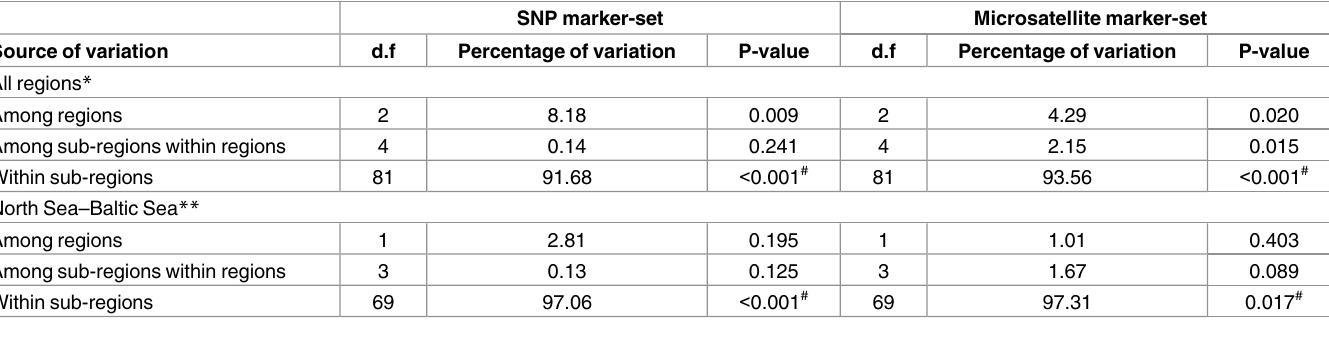
Table 4. Results of AMOVA for the SNP and microsatellite marker-sets performed for all regions and the North Sea to the Baltic Sea sub-regions. SNP marker-set Microsatellite marker-set Source of